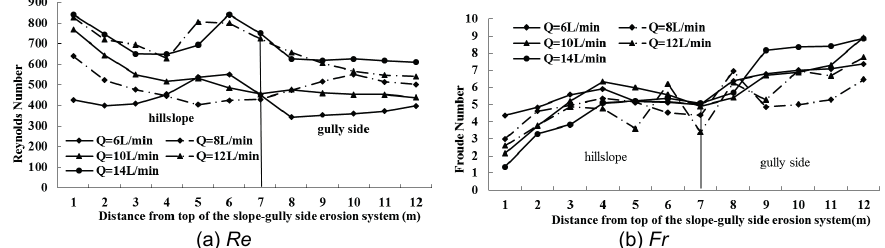
Fig. 3 Longitudinal variations of the Reynolds number ( Re ) and the Froude number ( Fr